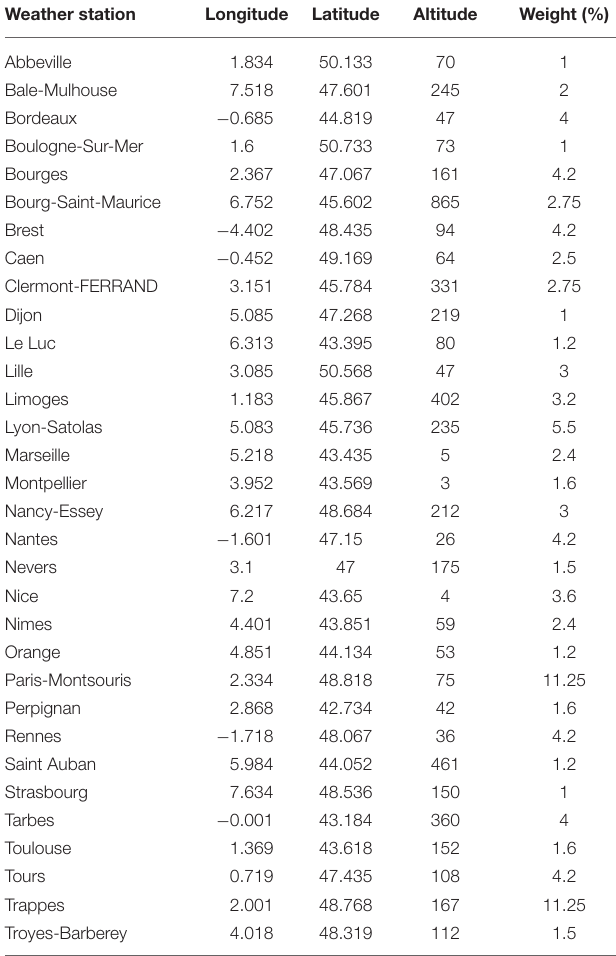
TABLE 1 | Weather stations for the temperature used to compute the thermal indicator for electricity demand in France, with their associated longitudes, latitudes, altitudes, and weights in the weighted